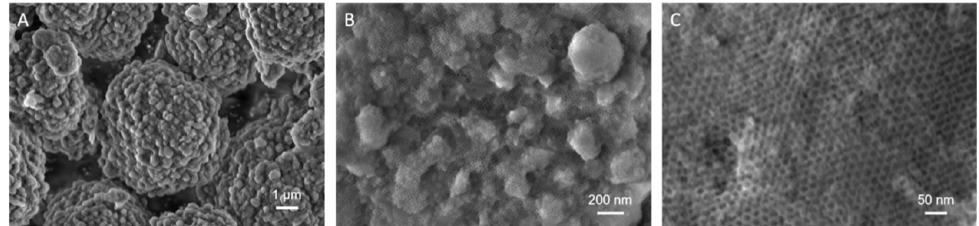
Figure 3. FE-SEM images of LPMS_140_24 at different magnifications: single particles ( A ), surface cage-like mesoporous network ( B , C ).